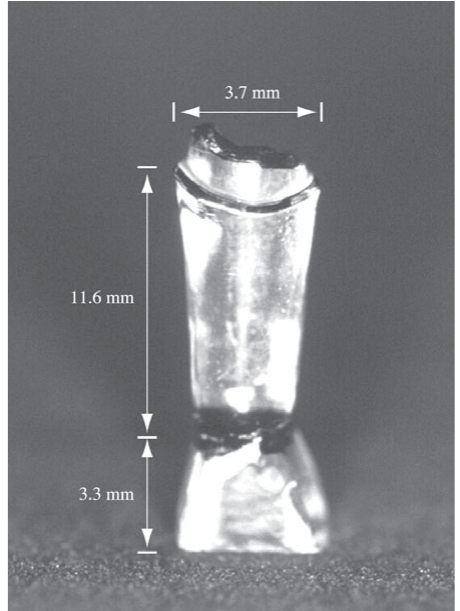
Figure 1 . Lateral view of the